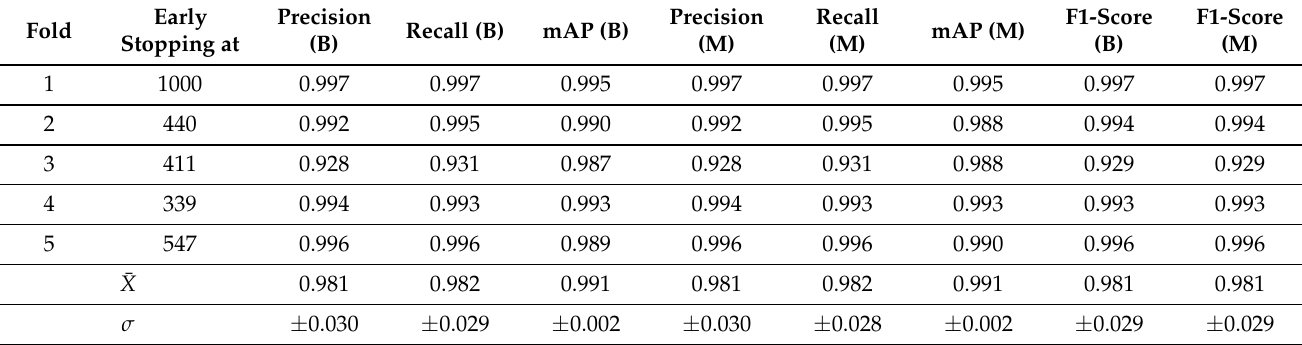
Table 8. Results for YOLOv5l